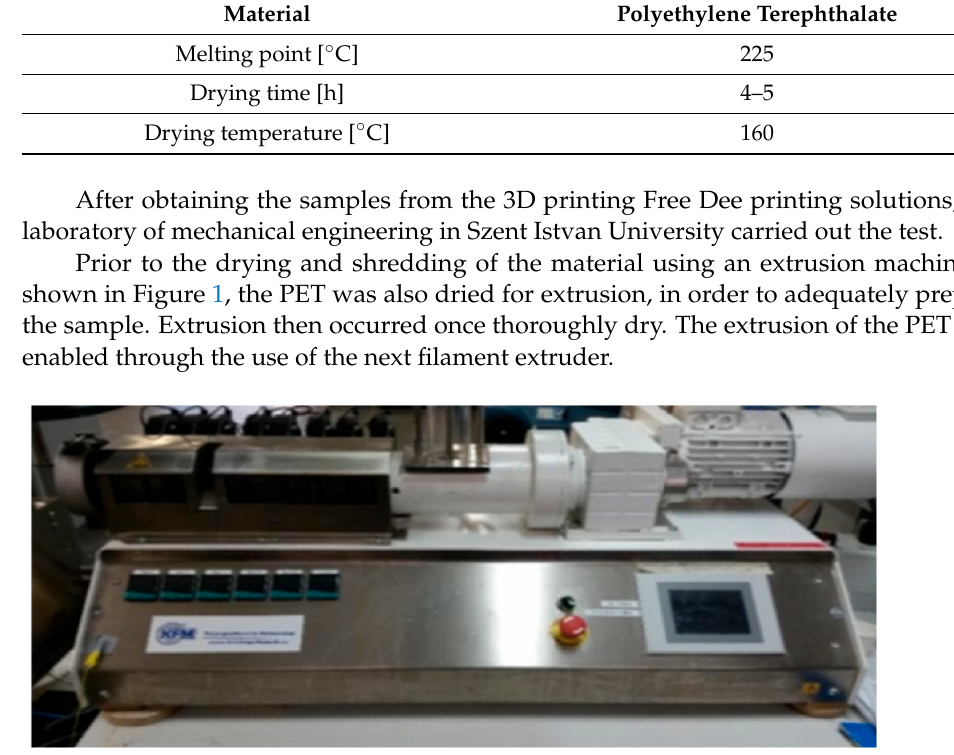
Figure 1. Sample of extrusion machine during the preparation of the specimens.